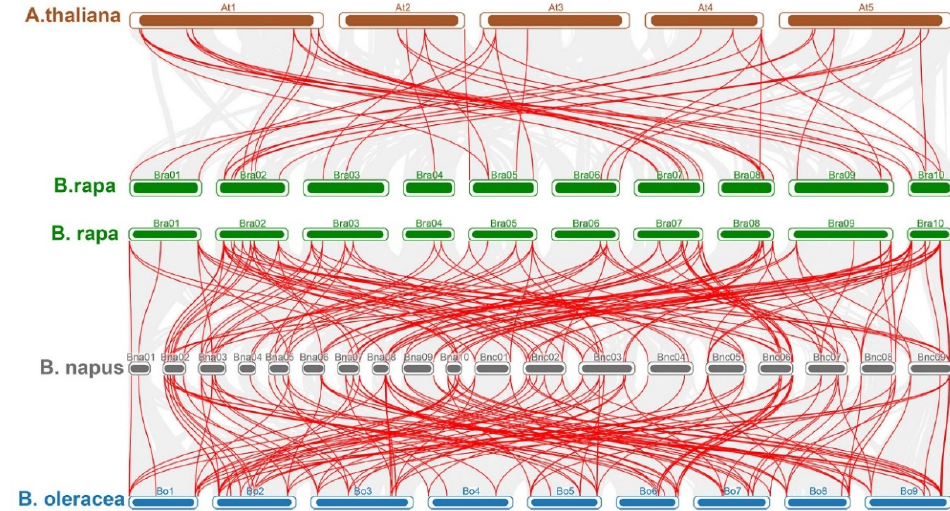
Figure 8. Syntenic collinearity relationship of B-box genes among A. thaliana and B. rapa , B. oleracea , and B. napus . In the background, gray lines designate the collinear blocks within the A. thaliana and other Brassica genomes. Diverse colored lines indicate the relationships among orthologous gene pairs between four Brassica species.